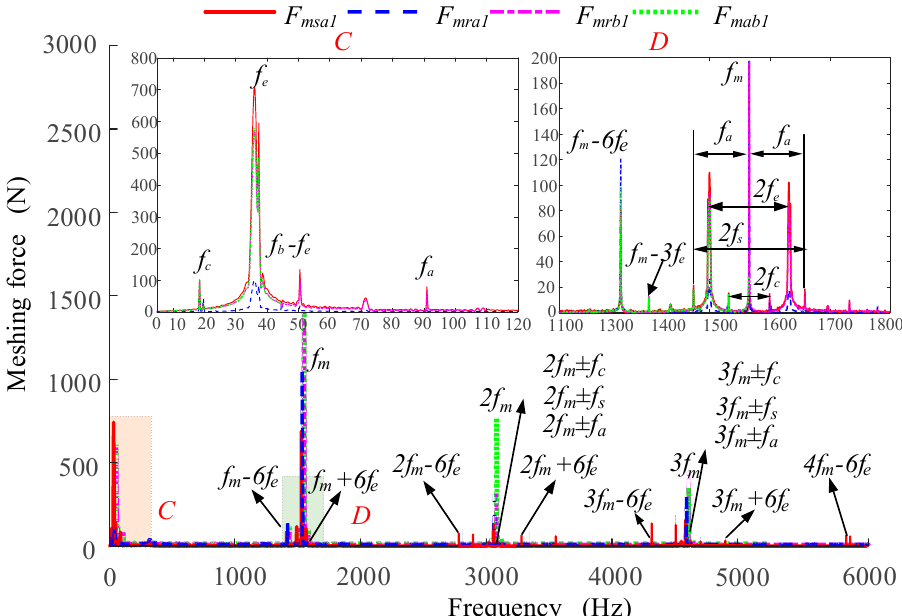
Figure 19. The spectrum of each meshing force.